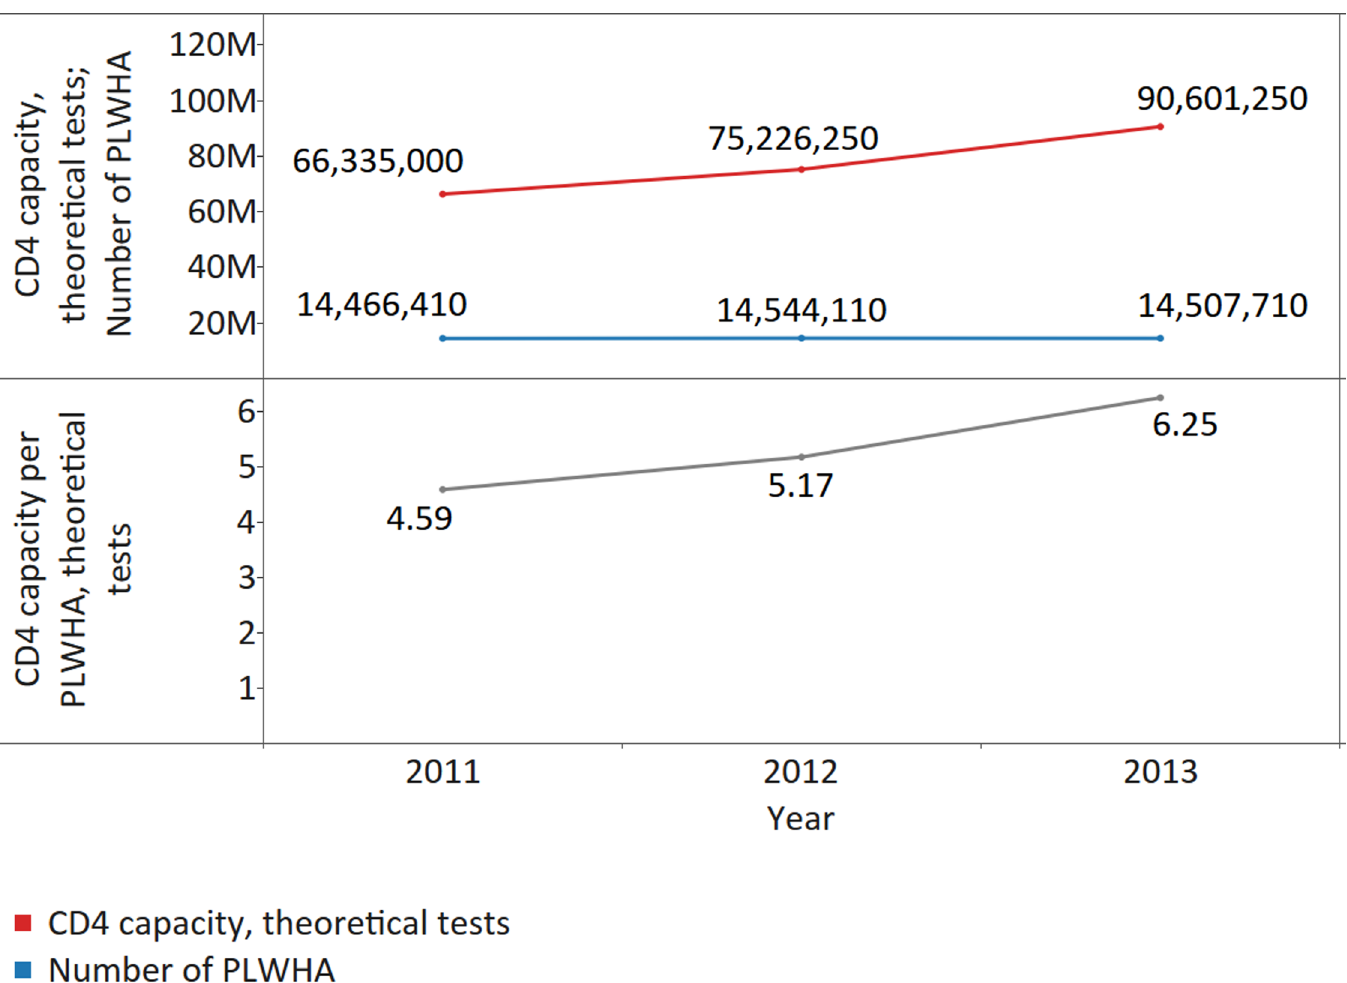
Fig 2. Increase in the theoretical CD4 capacity per people living with HIV/AIDS (PLWHA) across 39 countries providing data for 3 consecutive y. The upper panel shows the number of PLWHA and the theoretical CD4 capacity. The lower panel shows the CD4 capacity per PLWHA. The number of theoretical CD4 tests per PLWHA was calculated for 39 countries, because the number of PLWHA was not available for 1 country.